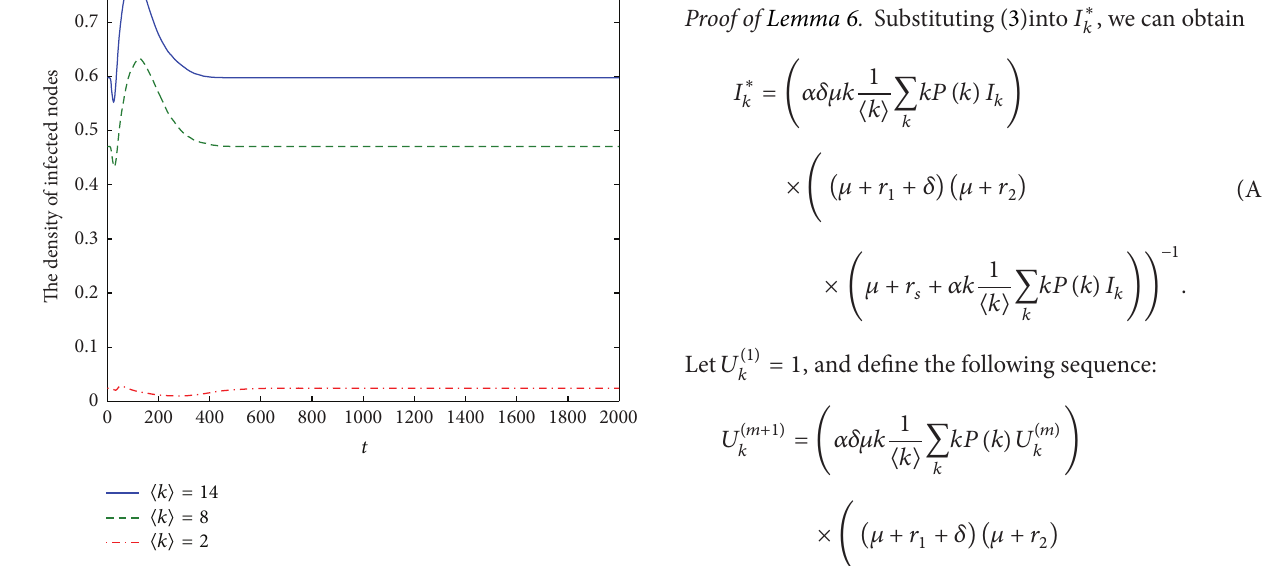
Figure 7: An illustration of the impact of average degree (⟨𝑘⟩) on the density of infected